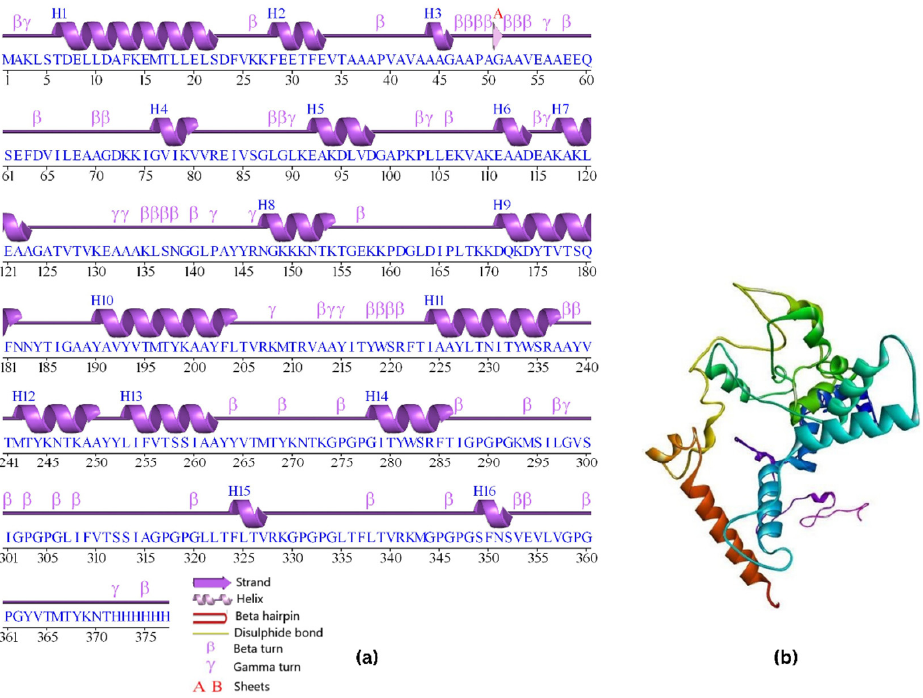
Figure 7. ( a ) Secondary structure of multi-epitope vaccine; ( b ) refined tertiary structure of multi- epitope vaccine.